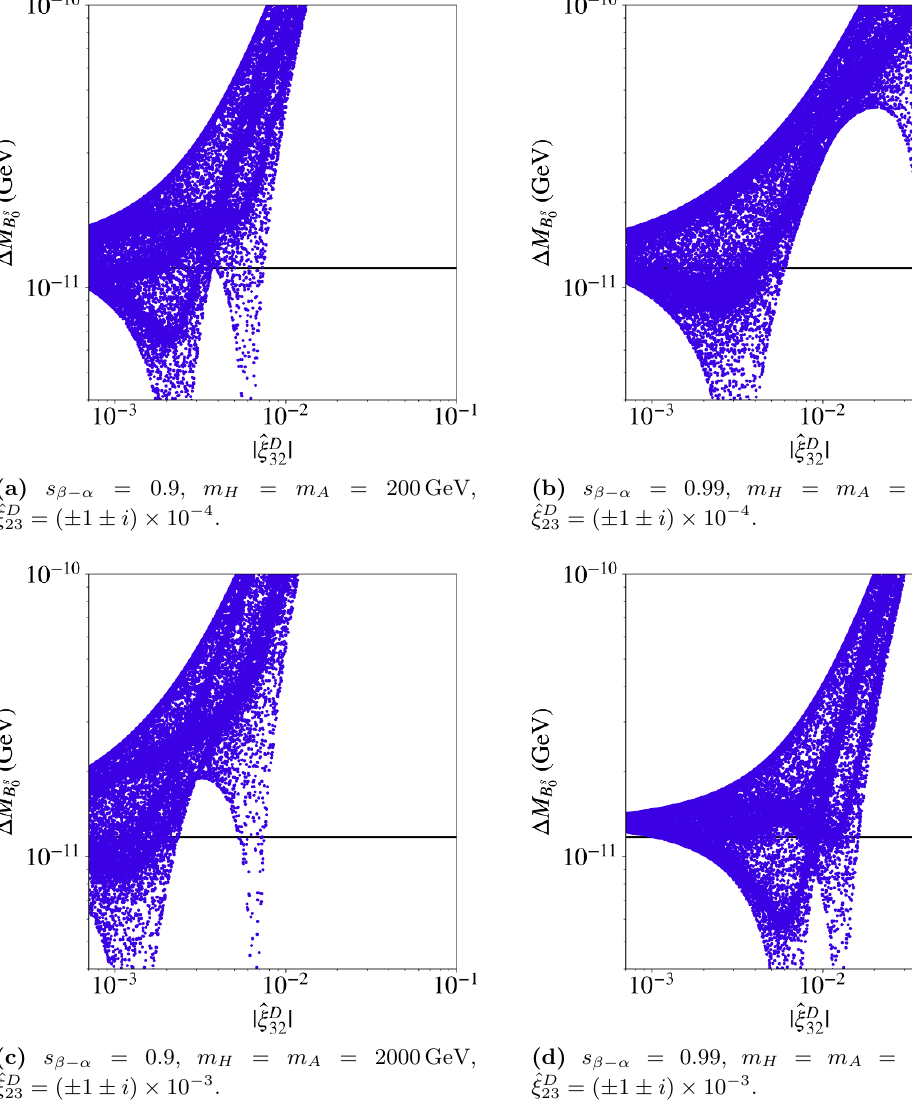
Figure 5 . (cid:1) M B in the 2HDM versus j ^ (cid:24) D j . The horizontal line shows the observed value (the 32 s corresponding error is smaller than the width of the line itself). The di(cid:11)erent values of s (cid:12) (cid:0) (cid:11) , m H , m A and ^ (cid:24) D used in the analyses are shown in each 23